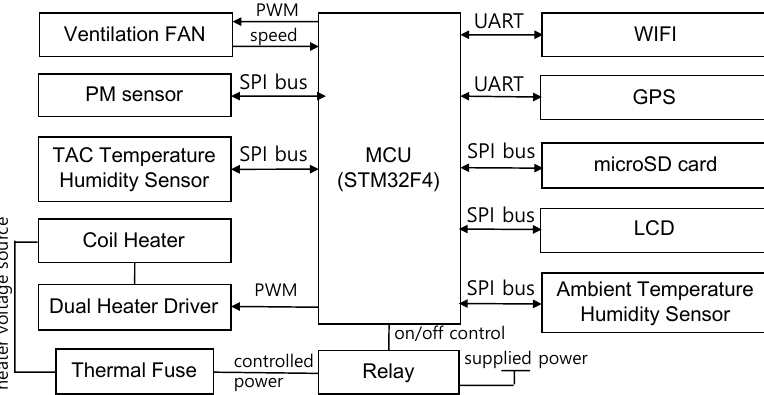
Figure 3. Block diagram of the proposed